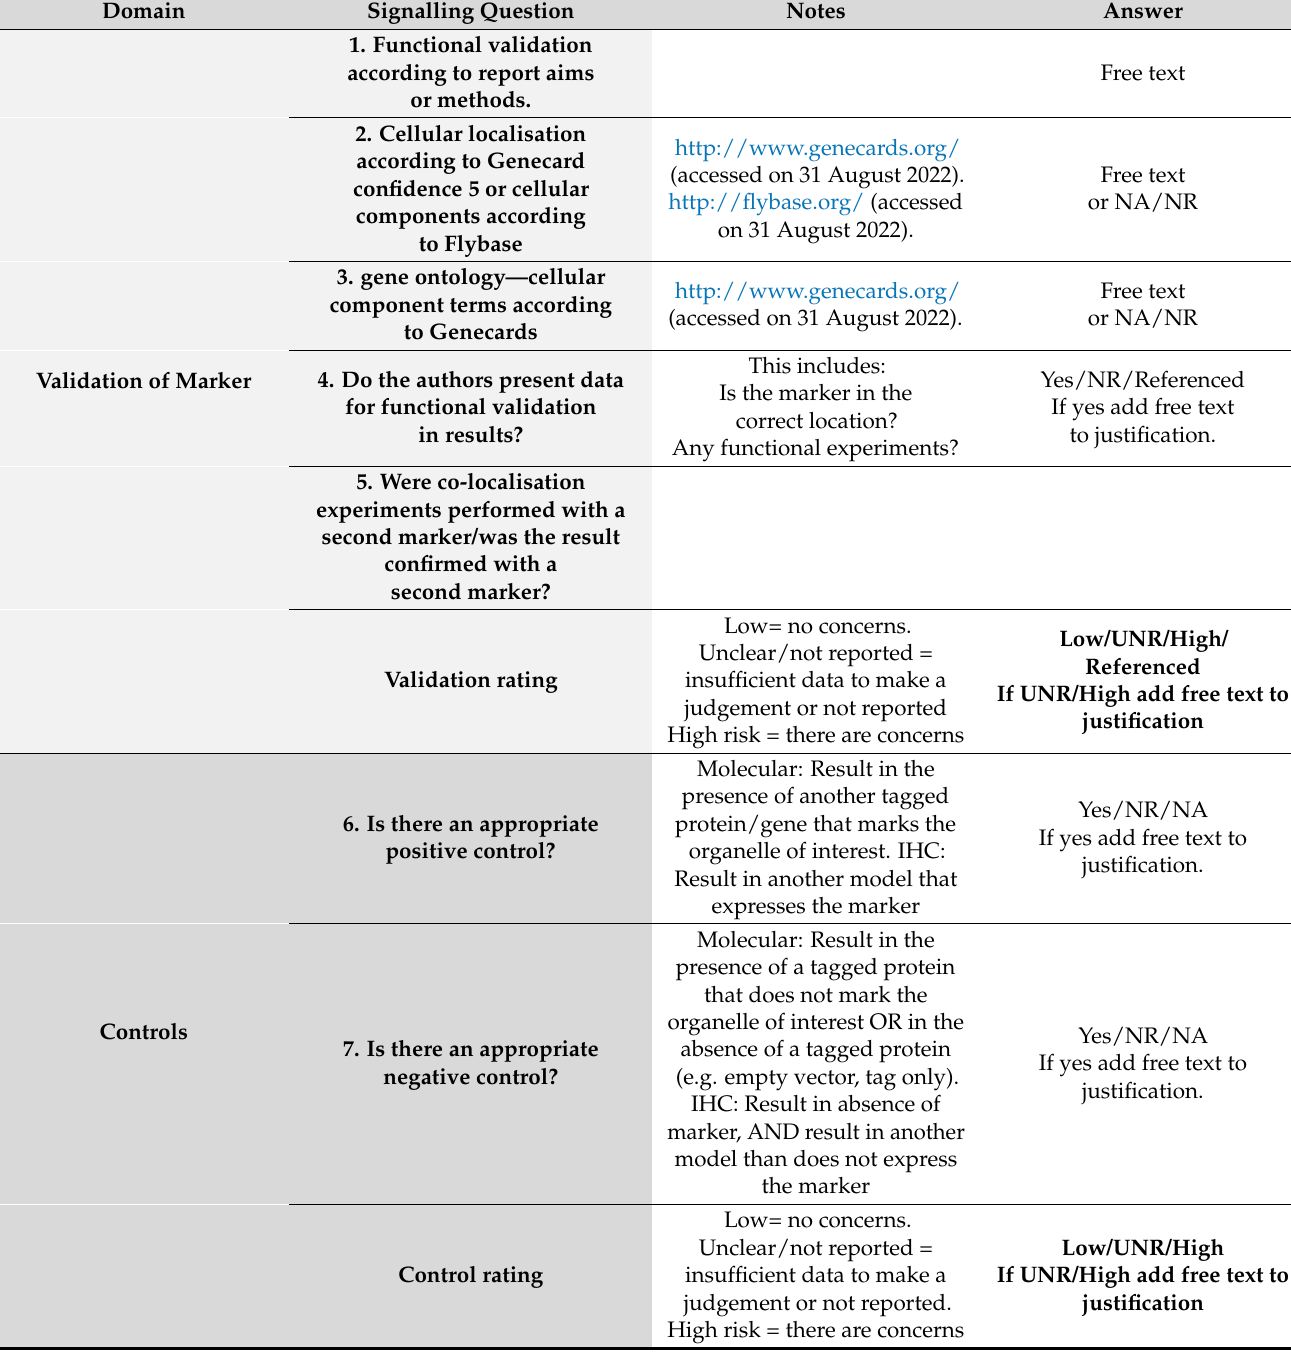
Table A6. Marker validity